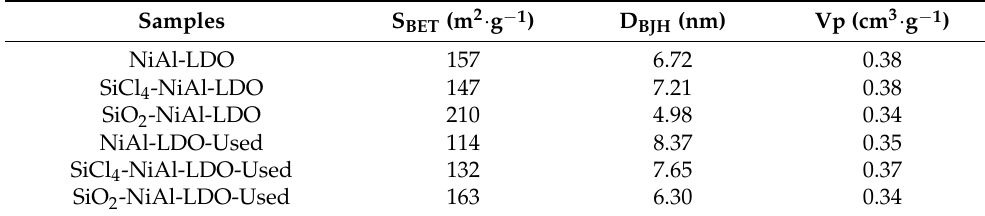
Table 1. Textural properties of the prepared